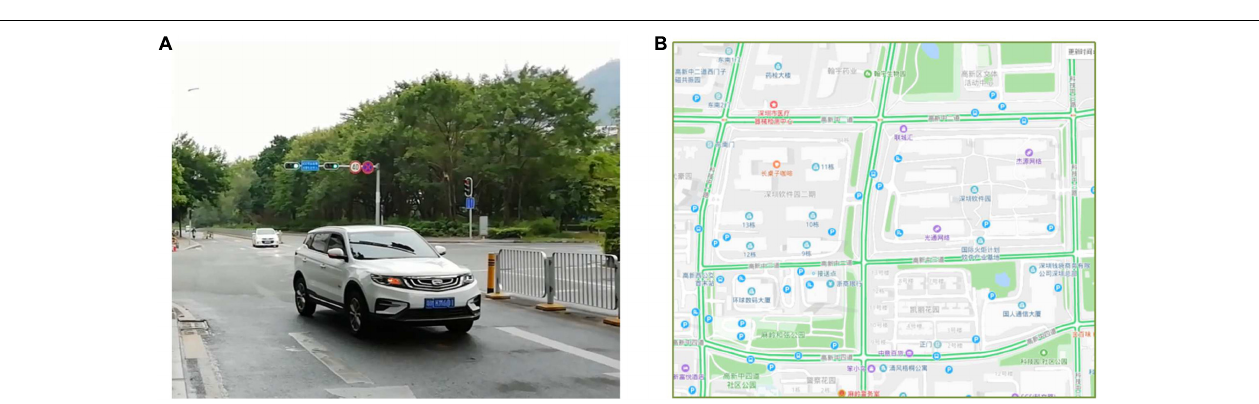
FIGURE 9 | Testing data acquisition: (A) The vehicle for collecting testing data; (B) urban roads for collecting testing data.